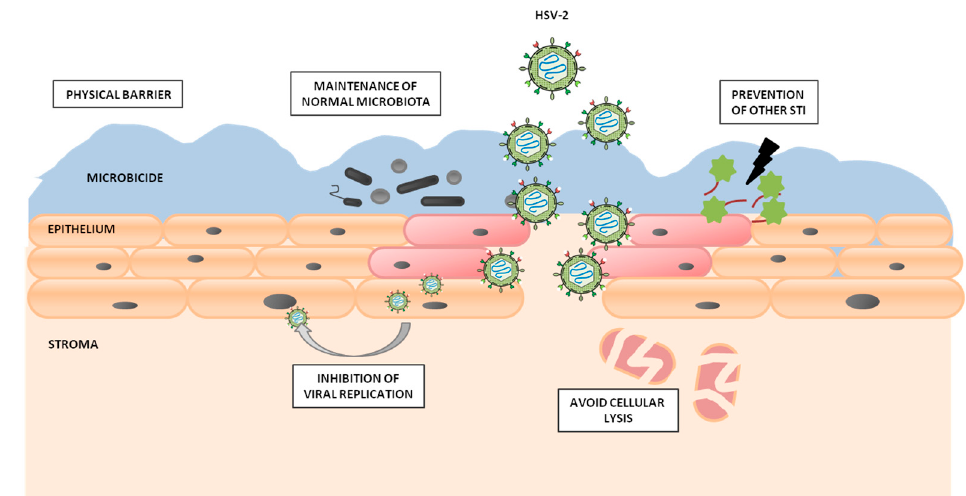
Figure 3. Schematic representation of the main goals in microbicide development. Microbicides must act as a lubricating layer that creates a physical barrier against infection with HSV-2, while also maintaining the vaginal defenses and inactivating the virus, even if it is able to cross the epithelial barrier.